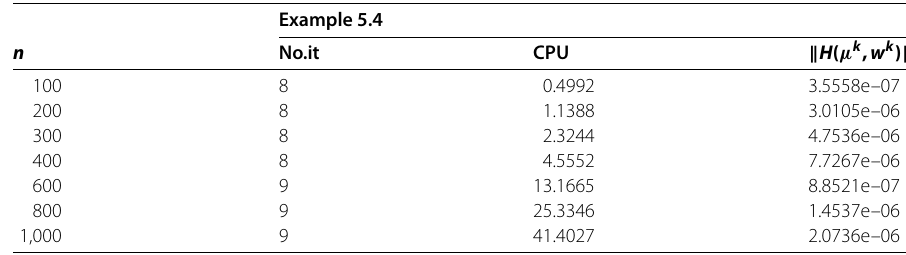
Table 4 Numerical results for Example